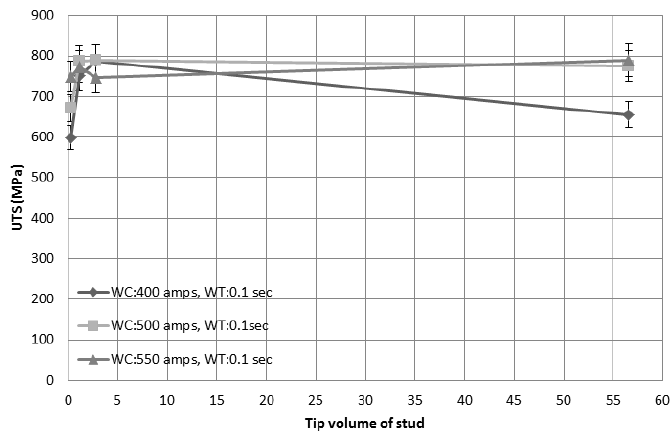
Figure 7. Interaction of ultimate tensile strength by tip volume of stud.